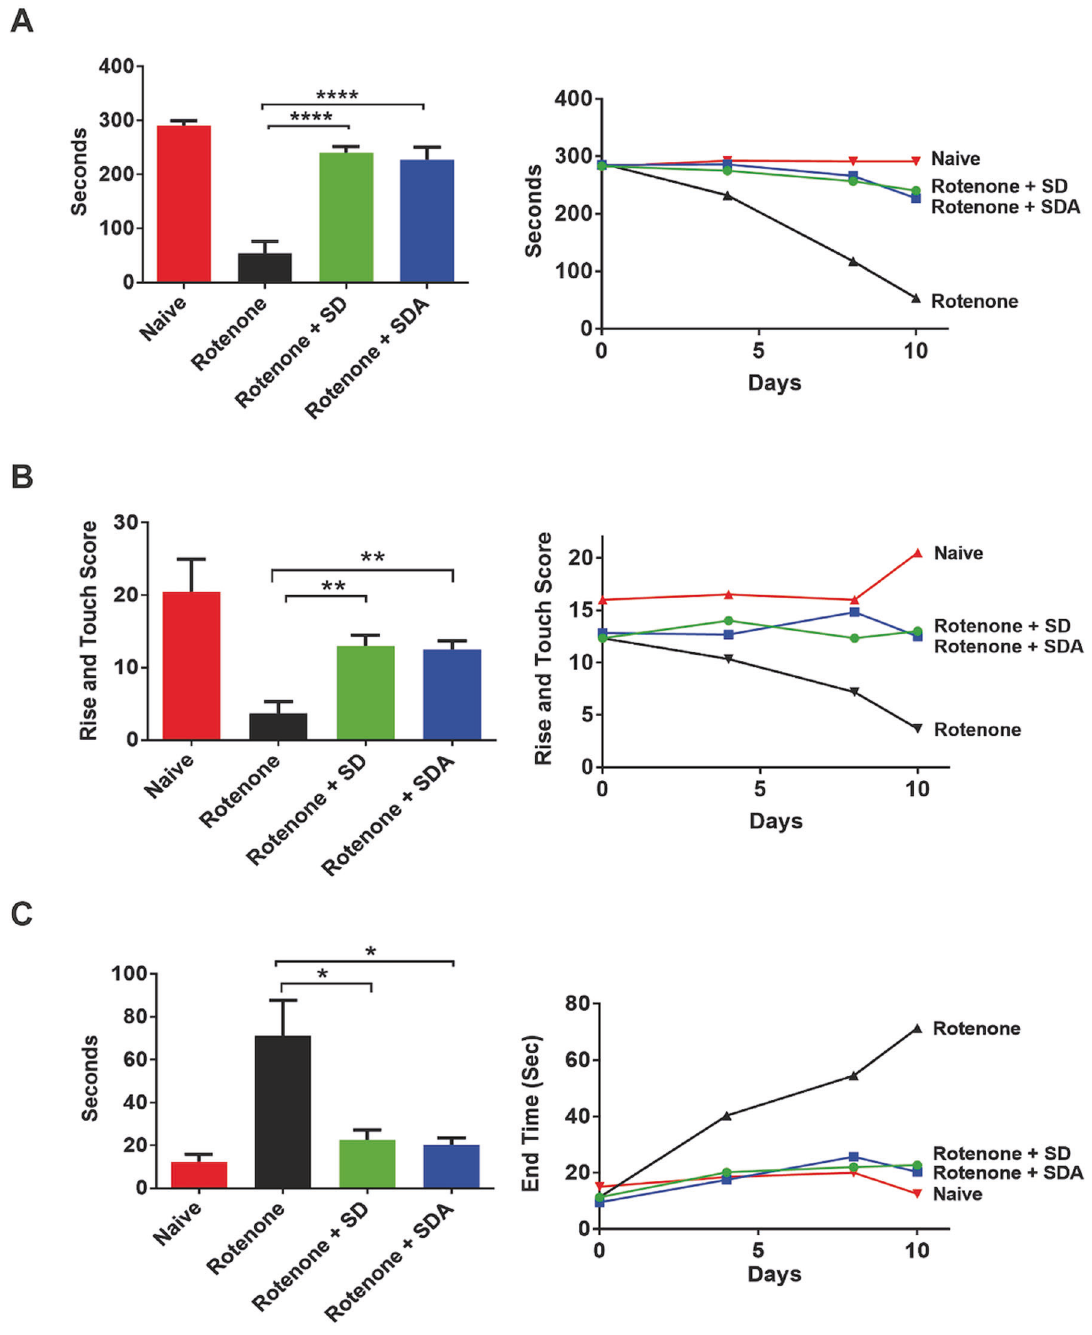
Fig. 3 SD and SDA rescue motor impairment in rotenone-treated rats. Rats were injected with rotenone alone (3 mg/kg; 10 days), or with either SD (33.3 mg/kg daily for 9 days) or SDA (33.3 mg/kg daily; 9 days). Motor activity was examined at days 4, 7, and 10 by A Rotarod assay monitored motor coordination. Apparatus was set to accelerate from 4 to 40 rpm in 300 s, and animals placed in separate lanes riding time B the Cylinder test which evaluated locomotor asymmetry by placing the rats in a clear glass cylinder (40 cm high and 20 cm diameter) and number of rears were counted during 5 min and ( C ) the walk bean assay which measured successful walk rats walk across an elevated 1 m long aluminum beam, counting the number of foot slips from the beam as a measure of locomotor co-ordination and